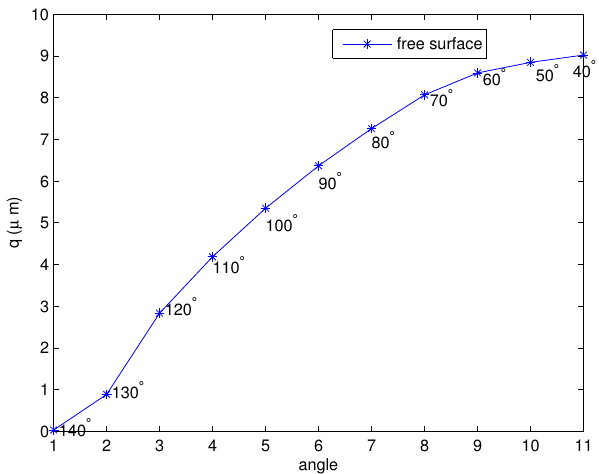
Figure 10. The free surface for the forward stroke at the tips of the